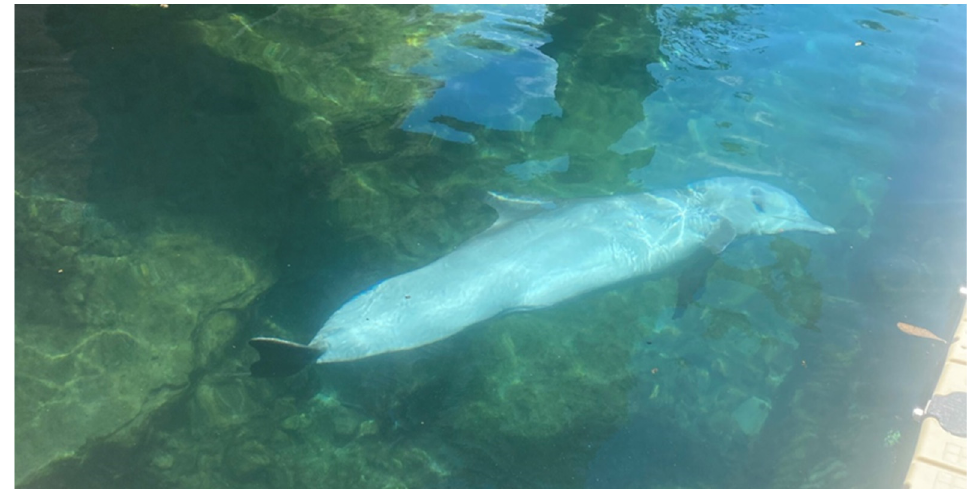
Figure 4. Dolphin Response. A look response to a playback. The underwater speaker source is be- hind a gate directly in line with the dolphin’s